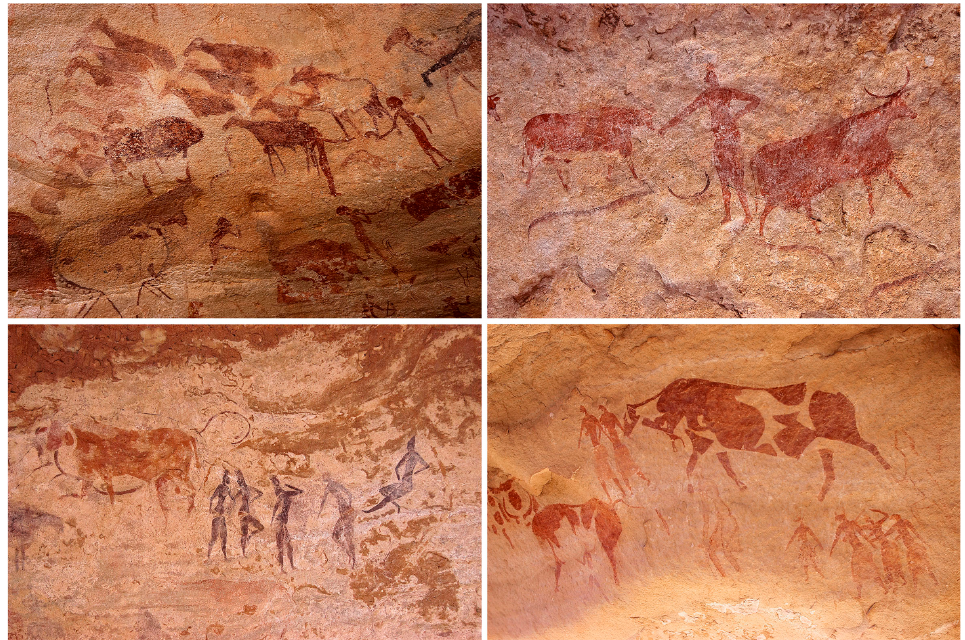
Figure 2. Rock art depicting pastoral scenes from Tassili n’Ajjer in Southern Algeria. Top left: sheep and goats in a row, probably tied with a rope; top right: figure of a herdsman with sub-Saharan anthropological features; bottom left: a pastoral scene painted in black and red (note that people in the middle have hairstyles reminiscent of the hair buns worn nowadays by the Fulani); bottom right: polychrome painting showing transhumance of a morphologically homogeneous herd of spotted cattle. Figures on the top are from the Sefar site, figures at the bottom from the Jabbaren site (Copyright: Viktor ˇCern ý